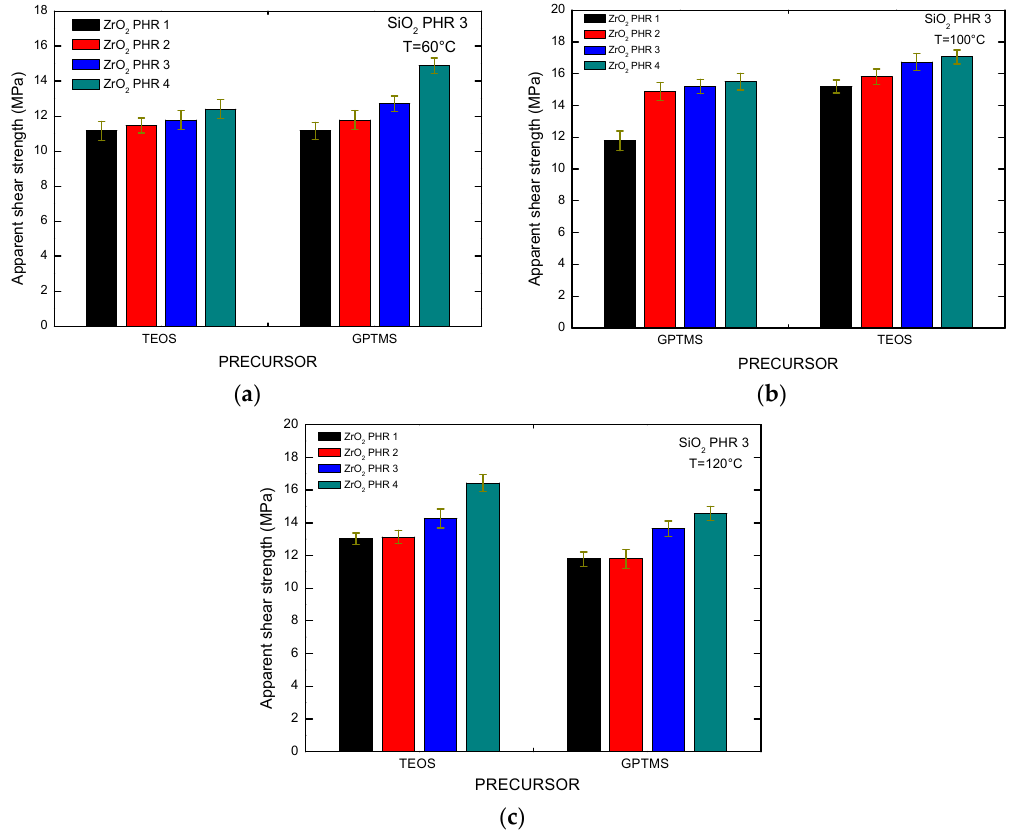
Figure 15. Apparent shear strength for epoxy-silica-zirconia adhesives with TEOS and GPTMS precursors at different temperatures: ( a ) T = 60 °C; ( b ) T = 100 °C; ( c ) T = 120 °C.